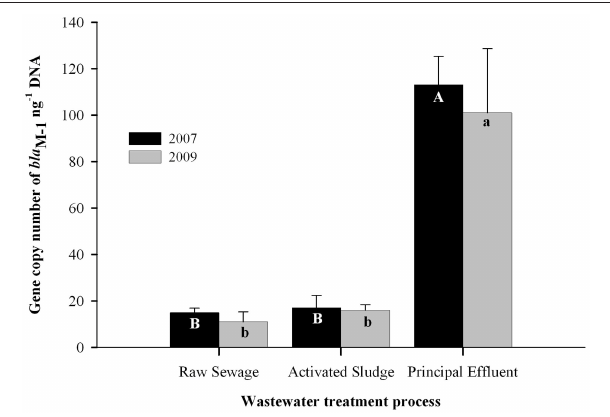
FIGURE 3 | The bla M − 1 gene levels in WWTP effluent from SC (modified after Uyaguari et al., 2011, Appl. Environ. Microbiol. 77: